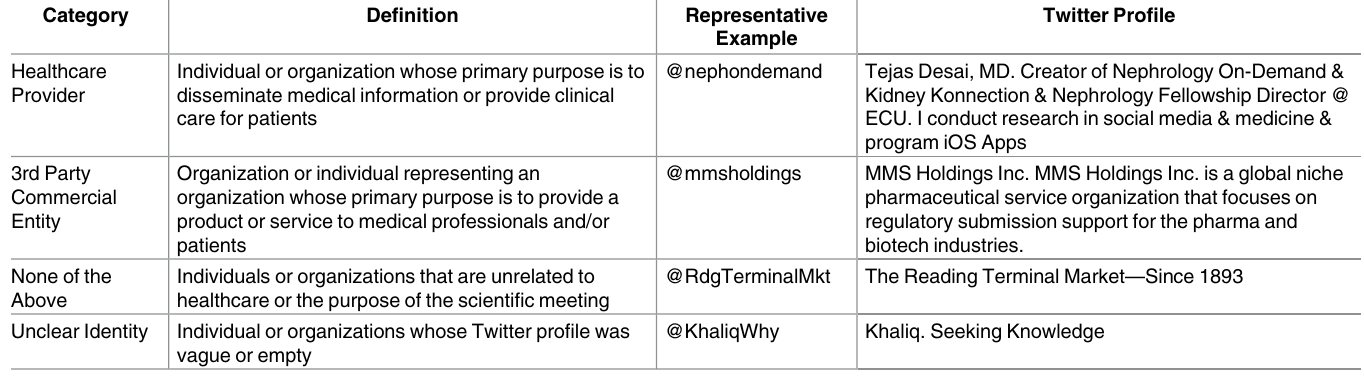
Table 3. User categories and